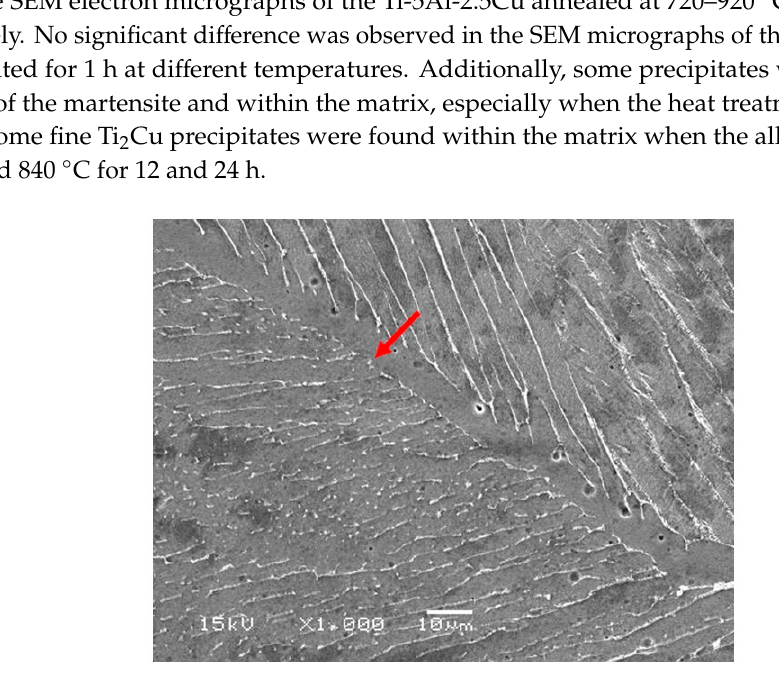
Figure 2. SEM electron micrographs of the specimens annealed at 720–920 °C for 1, 12, and 24 h (the red arrows indicate fine Ti 2 Cu precipitates). Figure 3. The X-ray diffraction (XRD) patterns of the Ti-5Al-2Cu alloys after different heat treatments.